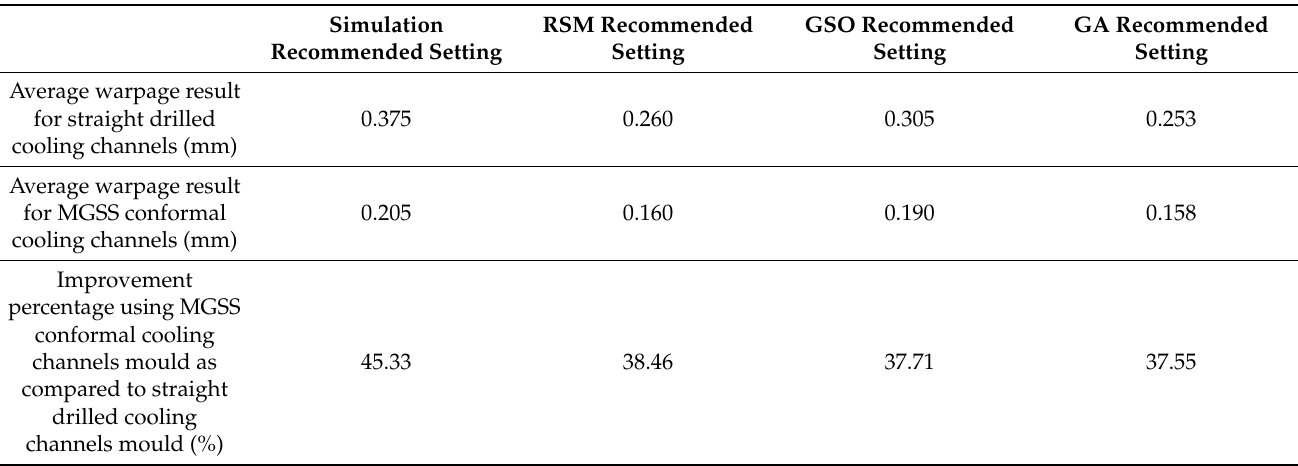
Table 8. Average warpage results on the front panel housing based on experimental works for both straight drilled and MGSS conformal cooling